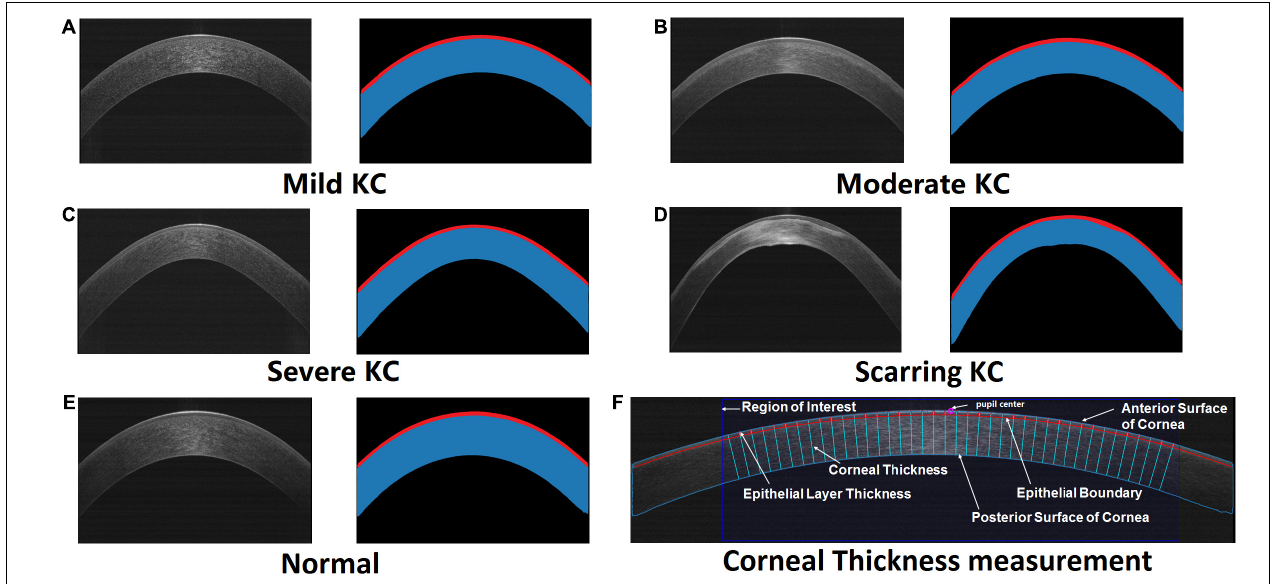
FIGURE 1 | The original AS-OCT images and their corresponding segmented maps generated by our trained deep learning networks. Red masks illustrate the segmented epithelial layers, while masks with red and blue are the segmented corneas. The representative cases included mild KC (A) , moderate KC (B) , severe KC (C) , scarring KC (D) , and normal eye (E) , respectively. (F) An example of the automatic corneal thickness measurement on resized AS-OCT image. The purple circle denotes the pupil center on the cornea. The dark blue rectangle stands for the studied region of interest. The sky-blue and red curves draw the anterior and posterior boundaries of the cornea including the epithelial layer. The normal lines of the corneal anterior surface represent the measurement of the epithelial layer thickness and corneal